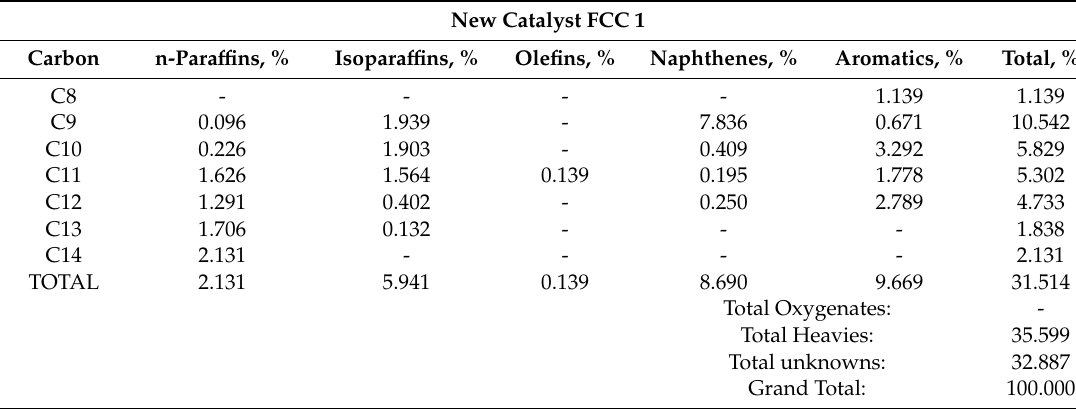
Table 22. Total composition results by group type and carbon number, as a percentage of the mass of catalyst New FCC